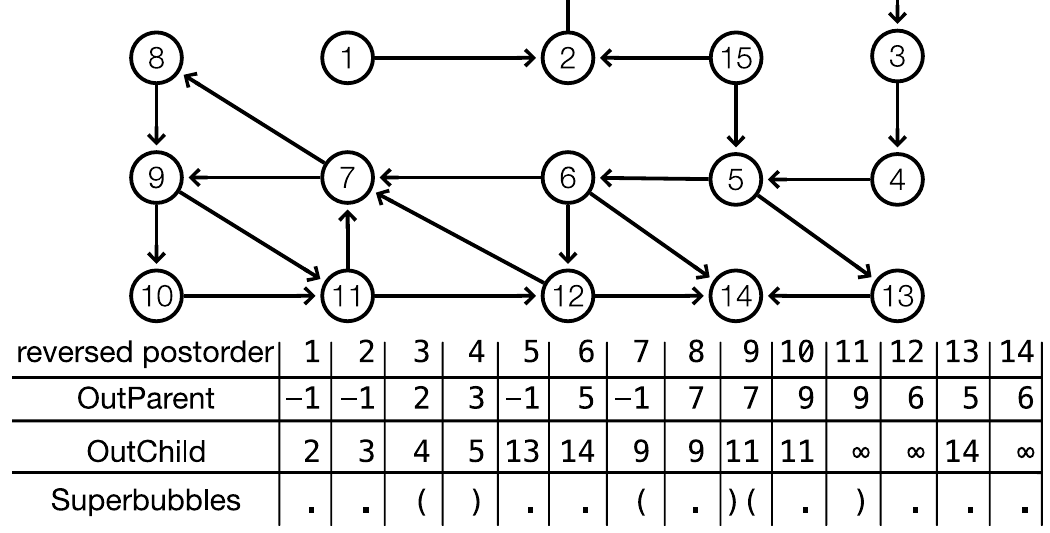
Figure 1. Illustration of the algorithm Superbubble on a digraph G with cycles. The top panel shows the input digraph. The DFS-tree T is rooted at one and covers V [ r ] = V ( G ) \ { 15 } . The table below gives the values of OutParent and OutChild as a function of the reverse postorder ¯ π of T . In the final line, matching pairs of parentheses indicate entrances and exits of the weak superbubbles in V [ r ] . This corresponds to the intervals that fulfill (F1) and